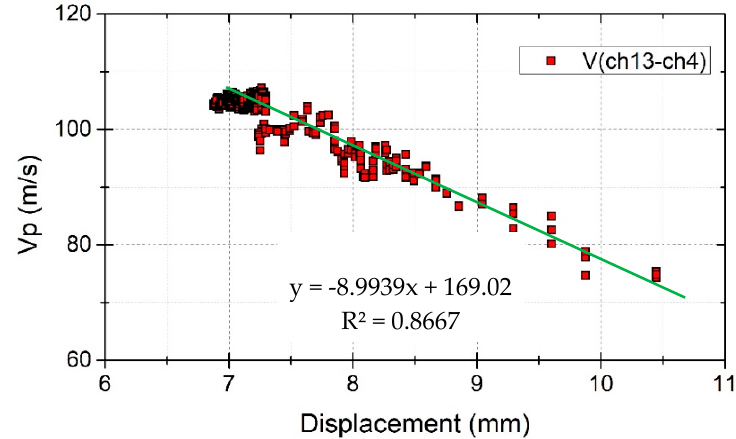
Figure 17. Wave velocity changes with displacement.